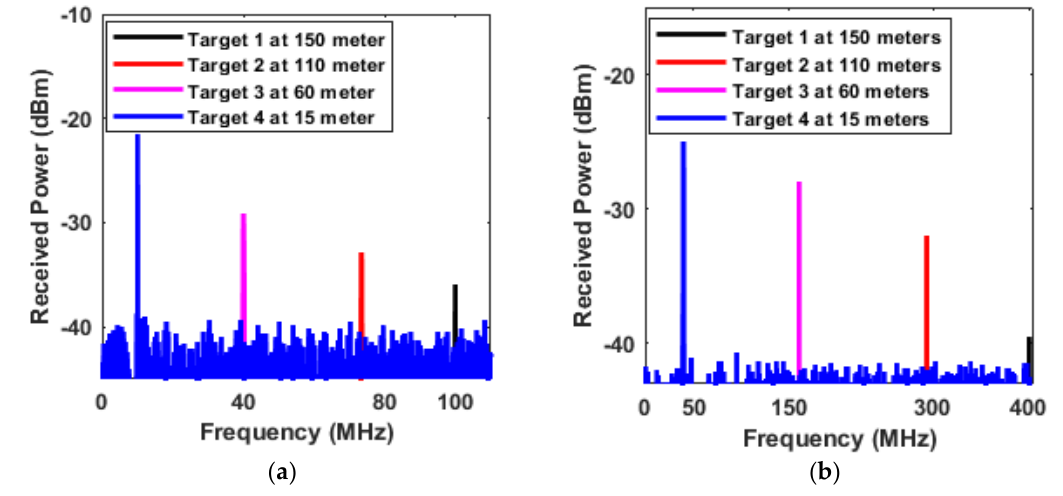
Figure 4. Power spectrum of de-chirped signal from multiple targets under adverse atmospheric conditions with attenuation of 50 dB/Km ( a ) at 1 GHz and ( b ) at 4 GHz bandwidth.